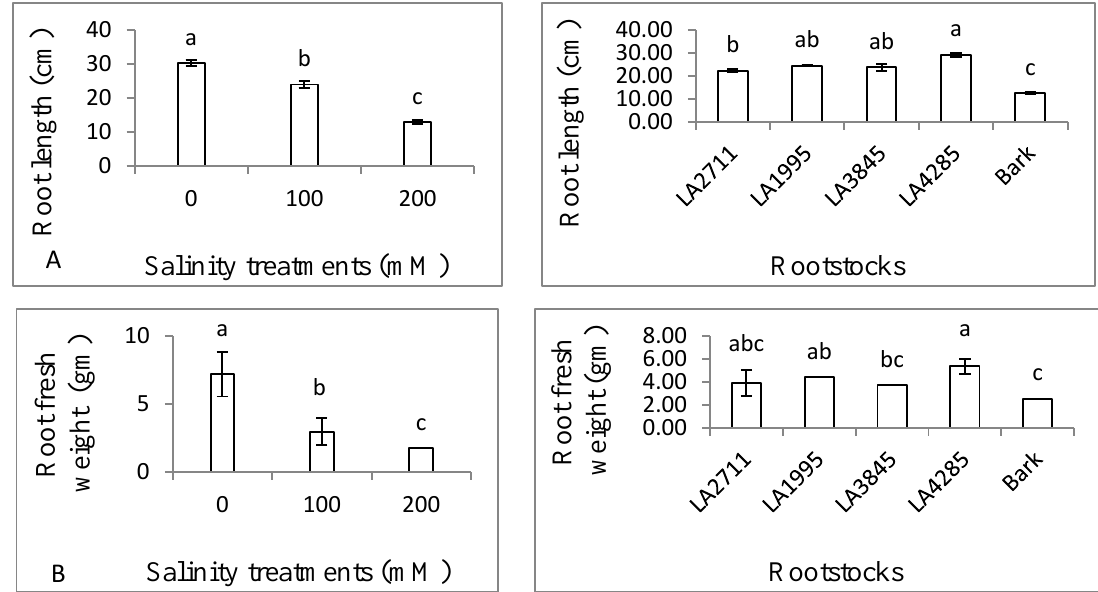
Table 6. Fresh weight attribute as affected by Salinity × Rootstock interaction.